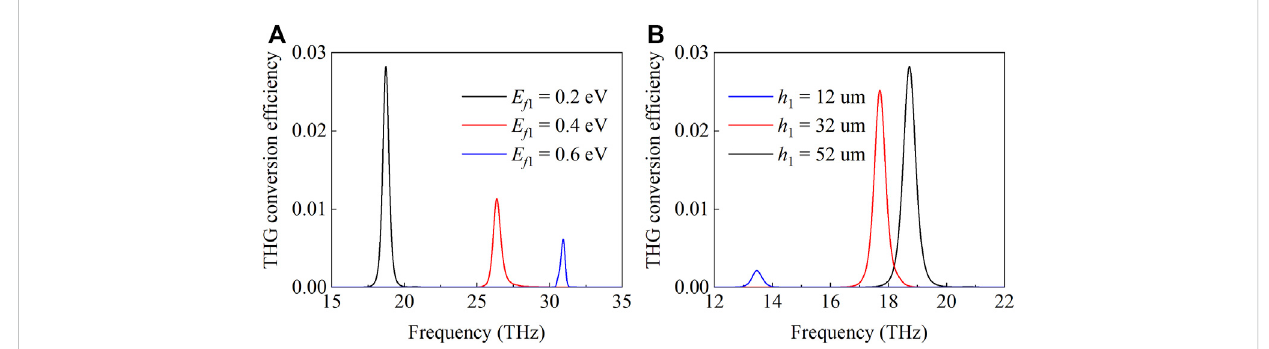
FIGURE 5 THGconversionef fi ciencyspectrafor (A) differentFermilevels E f 1 and (B) differentdistances h 1 .Theotherparametersare p =300 nm, w 1 =100 nm, h E f w 2 = 90 nm, 2 = 1,350 nm, and 2 = 1 eV.